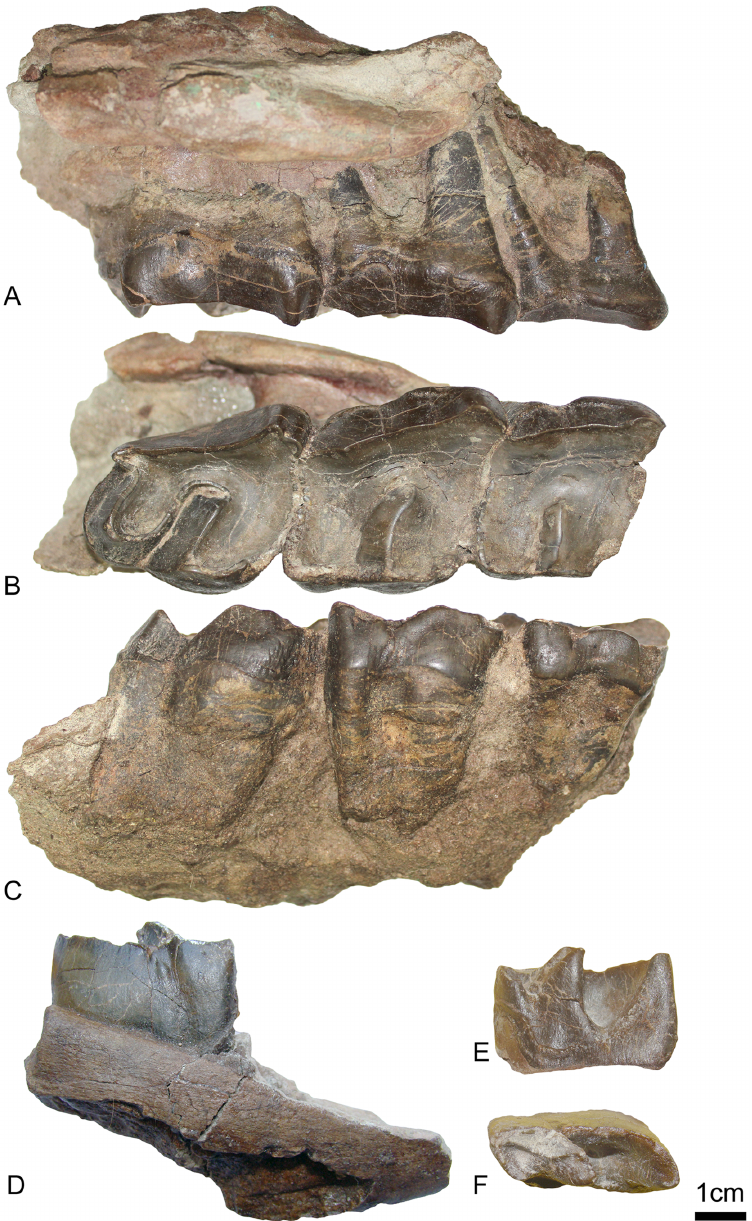
Fig 6. Amynodontopsis aff. bodei from Morlaca (Late Eocene; Romania). Right maxillary (UBB MPS V545) with M1-3 in labial (A), occlusal (B) and lingual (C) views. D: Right mandibular fragment from Morlaca (UBB MPS V546) with m1/2, in labial view. E: Lower right m1/2 from Morlaca (UBB MPS V546) in labial view. F: Lower right m1/2 from Morlaca (UBB MPS V546) in occlusal view.